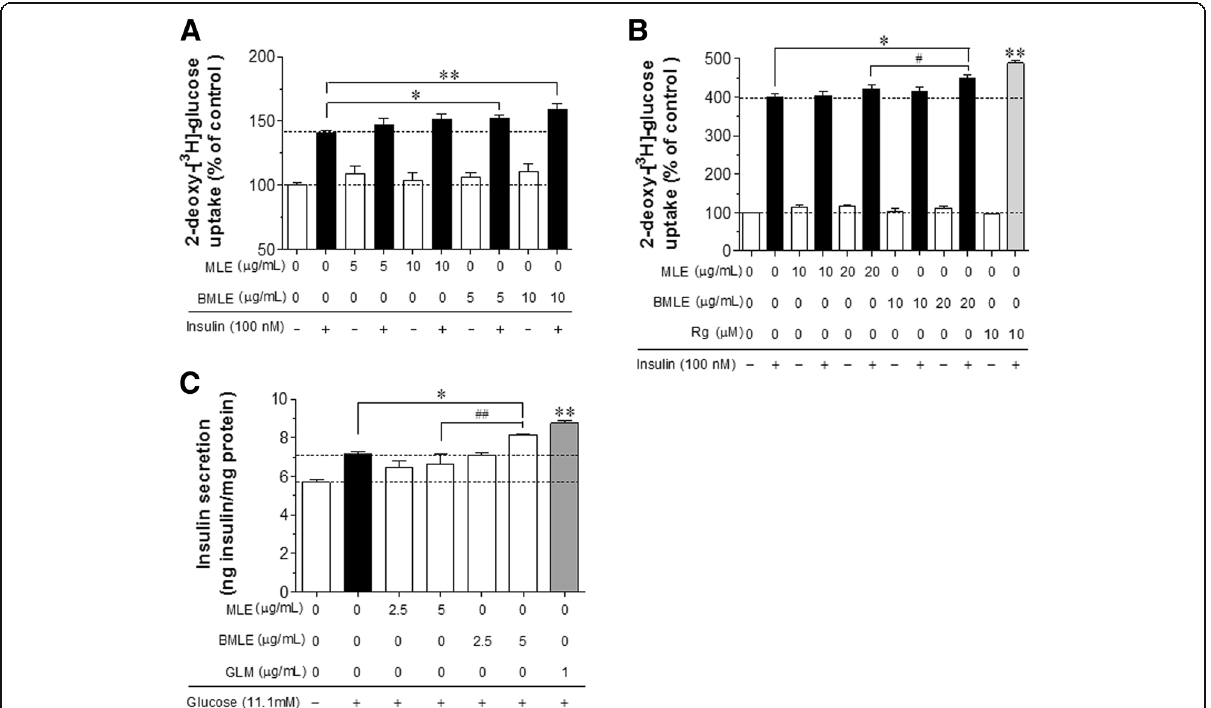
Fig. 2 Comparison of the abilities of bioconverted mulberry leaf extract (BMLE) and unaltered mulberry leaf extract (MLE) to improve glucose uptake and insulin secretion in ( a ) differentiated C2C12 myotubes, ( b ) 3 T3-L1 adipocytes, and ( c ) HIT-T15 pancreatic β -cells. To measure glucose uptake, cells were incubated in serum-starved DMEM for 1 h and then, treated with MLE, BMLE or rosiglitazone (Rg) for 1 h. The medium was changed to Krebs-Ringer phosphate-HEPES buffer containing the prescribed concentrations of MLE, BMLE or Rg for 30 min and then treated with 100 nM insulin for 30 min. After treatment with 2-deoxy-[ 3 H] – glucose (0.5 μ Ci/mL) and 2-deoxy-D-glucose (100 μ M) for 10 min, the reaction was terminated and glucose uptake activity was measured in lysed cells with a liquid scintillation counter (see Materials and methods). To measure insulin secretion, cells incubated with Krebs-Ringer bicarbonate-HEPES buffer containing 0.3% bovine serum albumin for 30 min were treated with 11.1 mM glucose and MLE, BMLE or glimepiride (GLM) for 1 h and the insulin concentration released into the media was measured (see Materials and Methods). Rg (10 μ M) and GLM (1 μ g/mL) were used as positive controls for glucose uptake in differentiated C2C12 myotubes and 3T3-L1 adipocytes and insulin release in HIT-T15 pancreatic β -cells, respectively. Data are expressed as the mean ± SEM of three